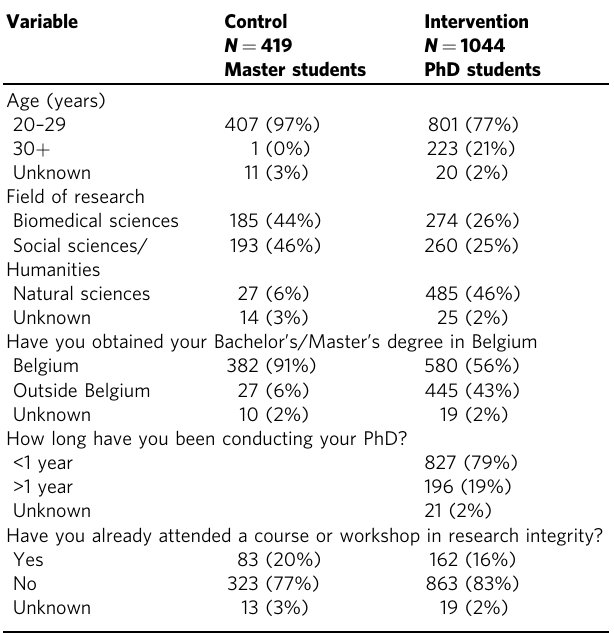
Table 1 Characteristics of survey participants at